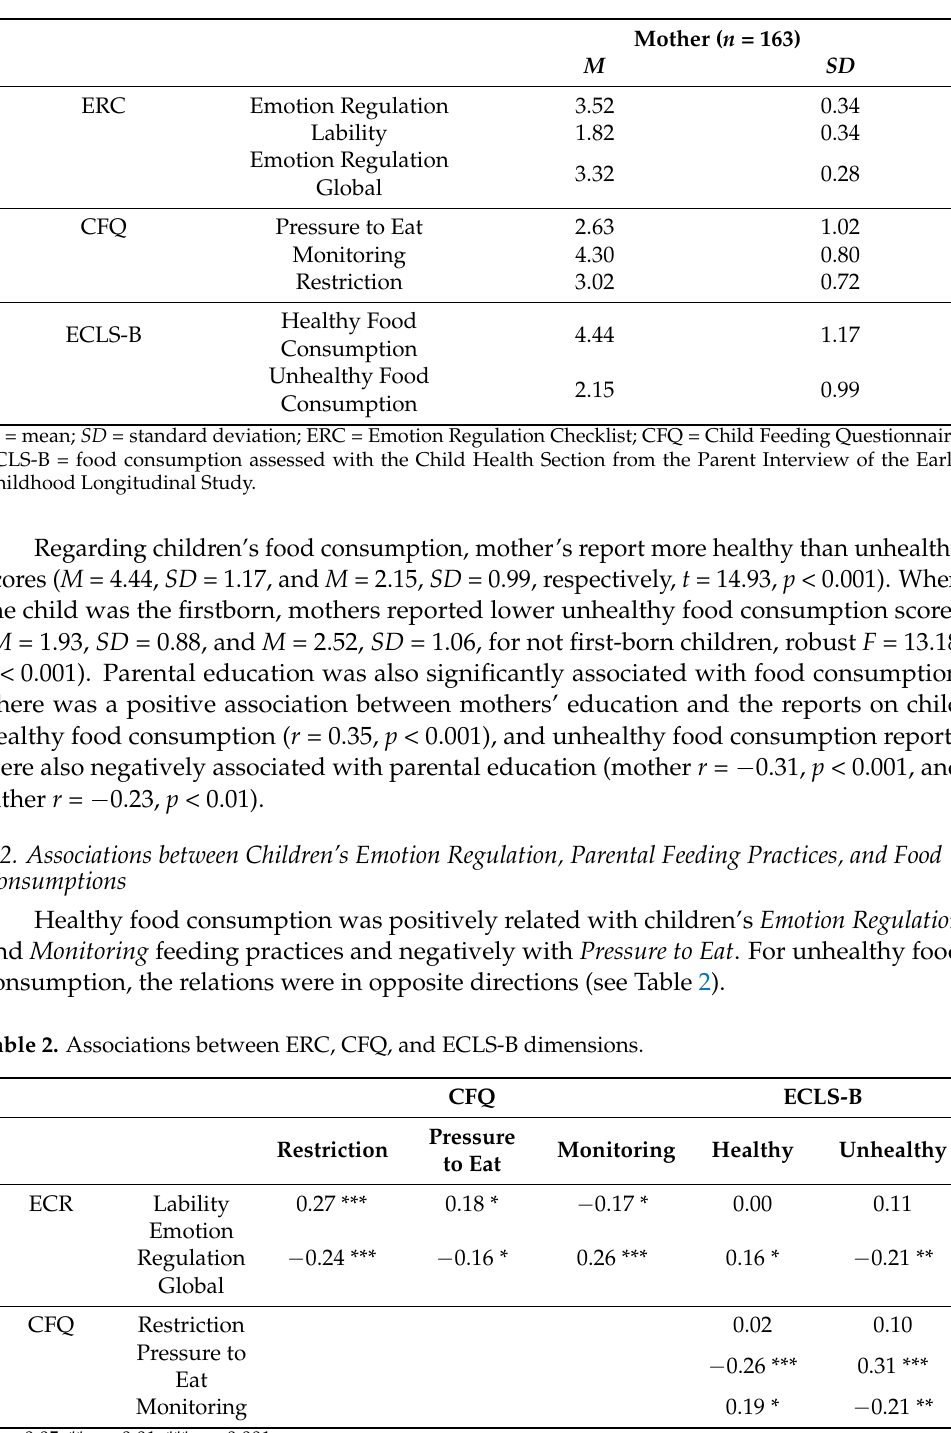
Table 1. Means and standard deviations regarding ERC, CFQ, and ECLS-B.